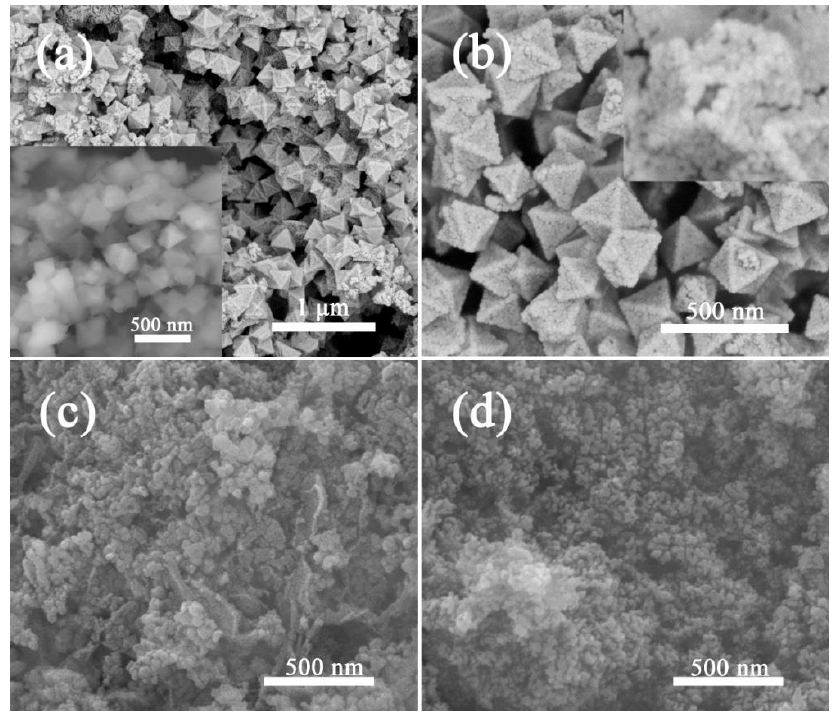
Figure 2. FESEM images of NiFe 2 O 4 nano-octahedrons in low ( a ) and high magnification ( b ), and NiFe 2 O 4 synthesized without DAB ( c ), or PTA ( d ). Insets show the FESEM images of NiFe-bimetallic MOFs ( a ) and the hollow interior of NiFe 2 O 4 ( b ).